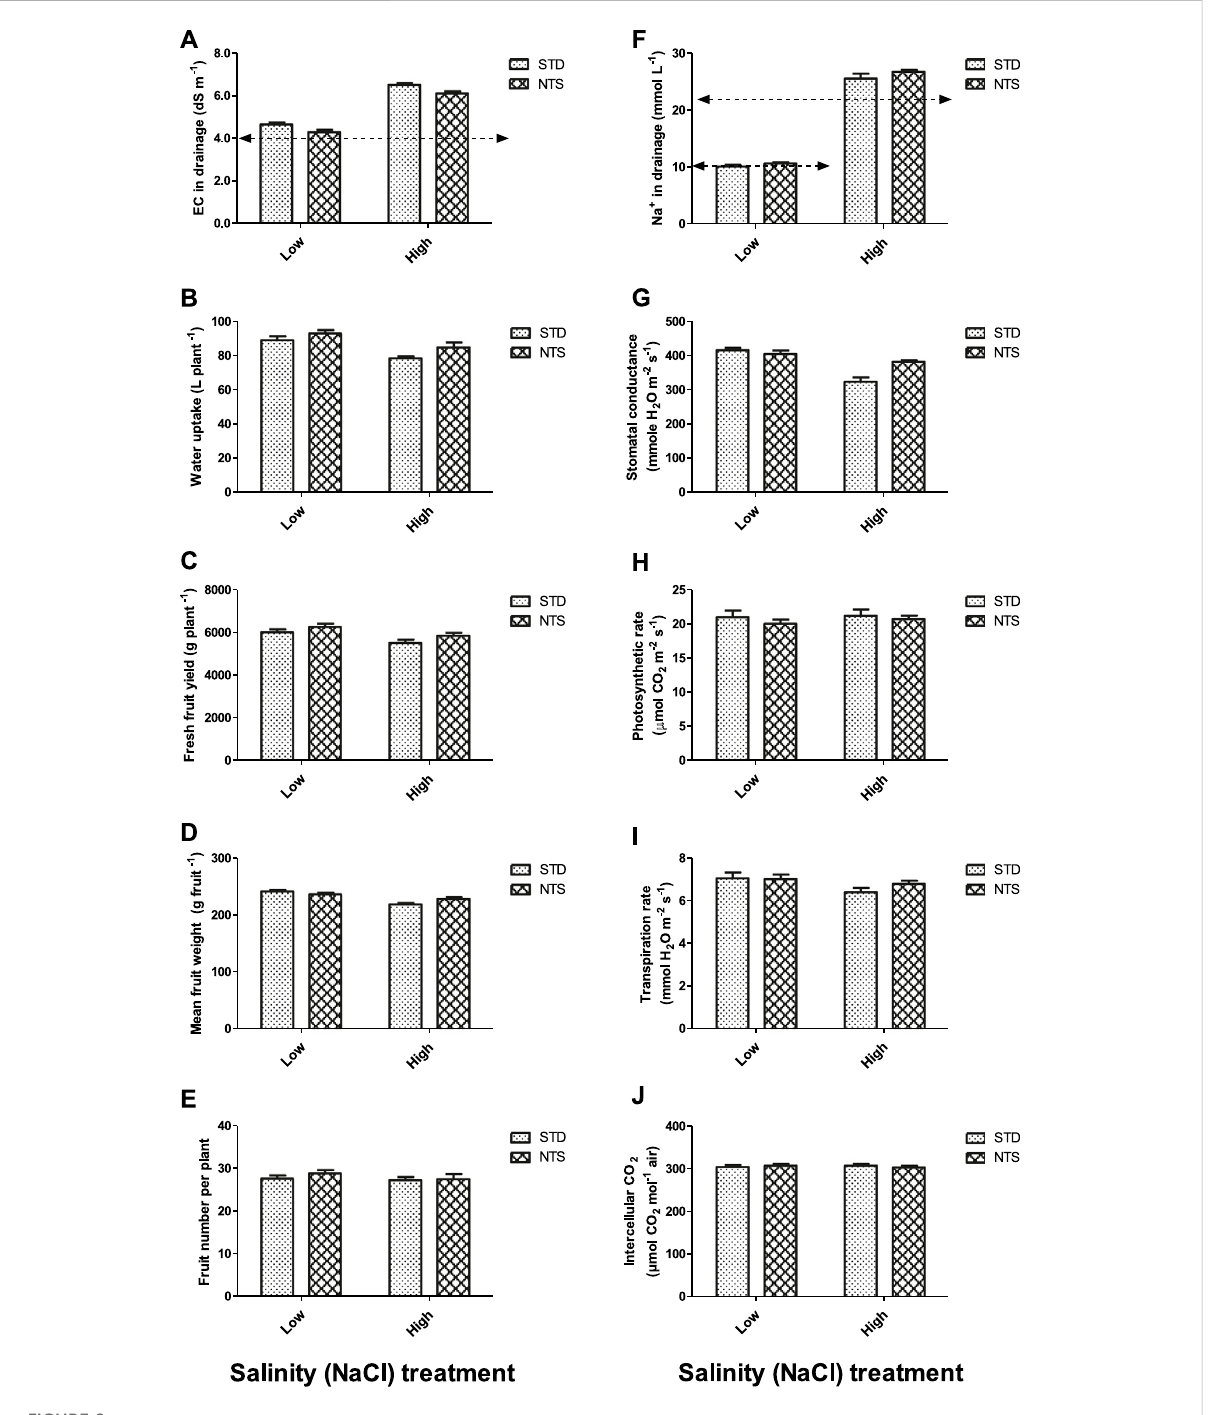
FIGURE 2 Agronomical (A – F) (root zone electrical conductivity-EC, water uptake, fresh fruityield, mean fruit weight, fruitnumber per plant, and drainage sodium-Na concentration) and physiological (G – J) (Stomatal conductance, Photosynthetic rate, Transpiration rate, and Intercellular CO 2 concentrations) responses in hydroponic tomato crops supplied with nutrient solution compositions provided by two nutritional strategies (i.e., standard-STD and nutrisense-NTS) under low- and high-salinity (NaCl) levels. “ STD ” corresponds to a typical replenishment strategy in whichwaterandnutrientswereaddedinthesystembasedonpredeterminednutrienttowateruptakeratiostermednutrientuptakeconcentrations- UCsand “ NTS ” correspondstoanalternativereplenishmentstrategy inwhich,waterandnutrientswereaddedinthesystembasedonreadjustments of target nutrient UCs. Salinity (NaCl) treatments wereestablished by adding NaCl at appropriate amounts inthe primary water containing 1.6 mM of NaCl (Low) to increase the NaCl concentration to 5.0 mM (High). Vertical columns in fi gure parts are means of four replicates ± standard